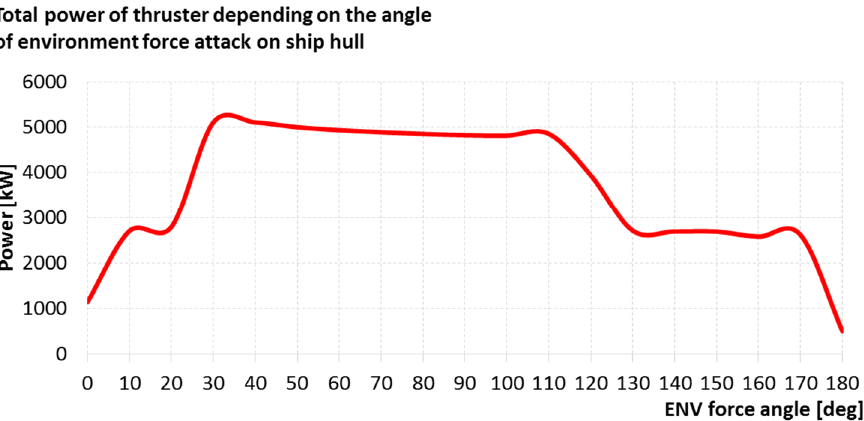
Figure 6. The sum of the powers of individual thrusters depending on the angle of attack of environmental forces.